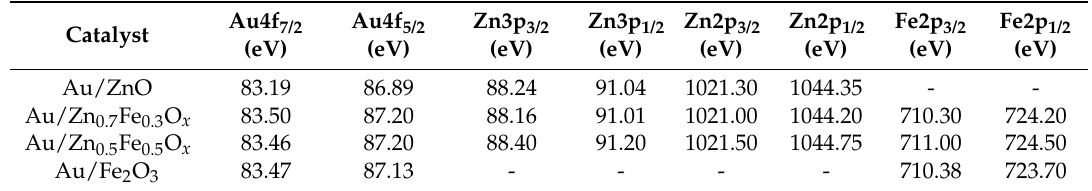
Table 3. Data from the XPS analyses of the selected nanocatalysts.